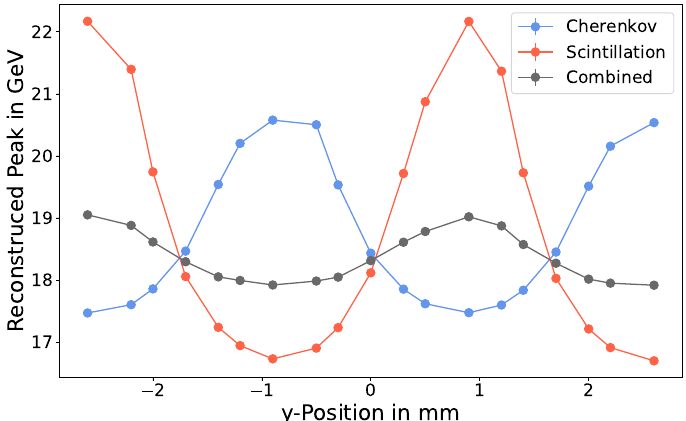
Figure 4. Reconstructed energy deposit as a function of the beam impact position for the Cherenkov, scintillation, and combined